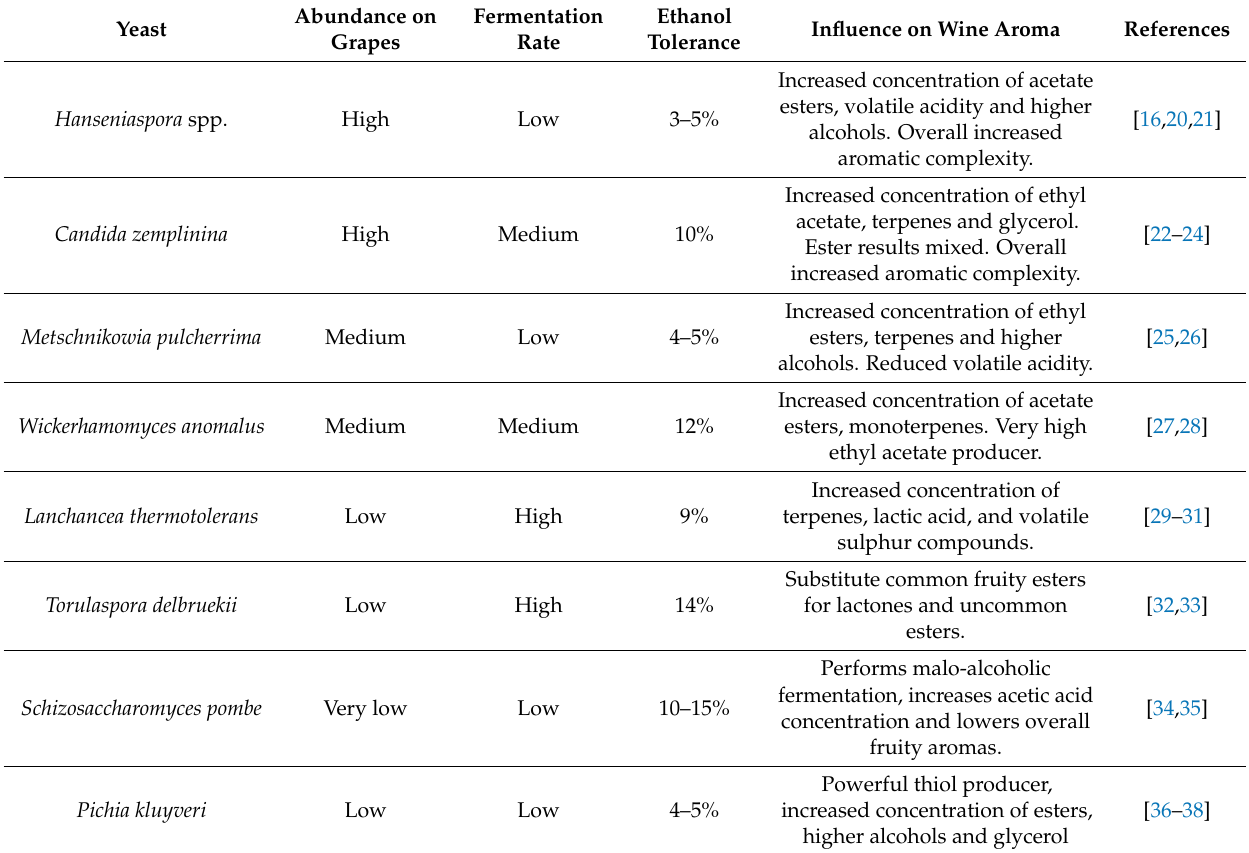
Table 2. Non- Saccharomyces yeasts with great oenological